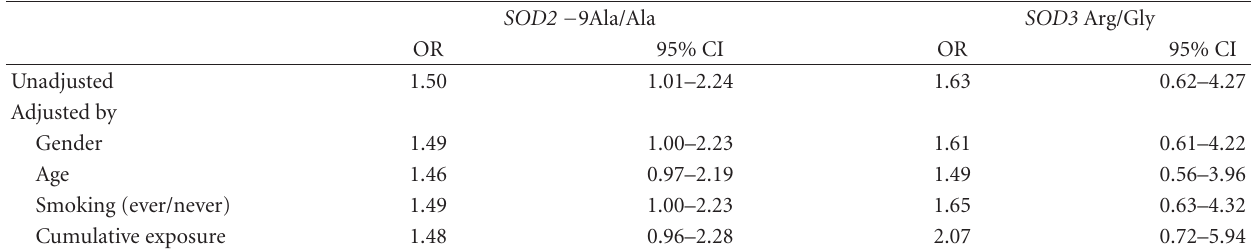
Table 3: Risk of asbestosis for the SOD2 − 9Ala/Ala versus combined Ala/Val and Val/Val genotypes and SOD3 Arg/Gly genotype compared to Arg/Arg genotype after adjustment by gender, age, smoking, and cumulative asbestos